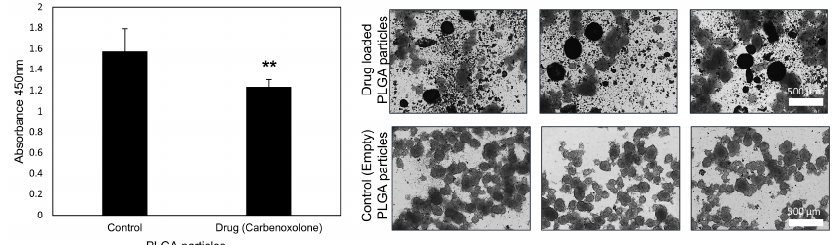
Figure 3. Carbenoxolone-loaded particles increase cell susceptibility to anoikis. Anoikis assay using poly(2-hydroxyethyl methacrylate) (p-HEMA) coated plates on Lewis lung carcinoma (LLC), after 72 h of incubation with 0.5 µM carbenoxolone encapsulated particles (empty particles for control). n = 5.